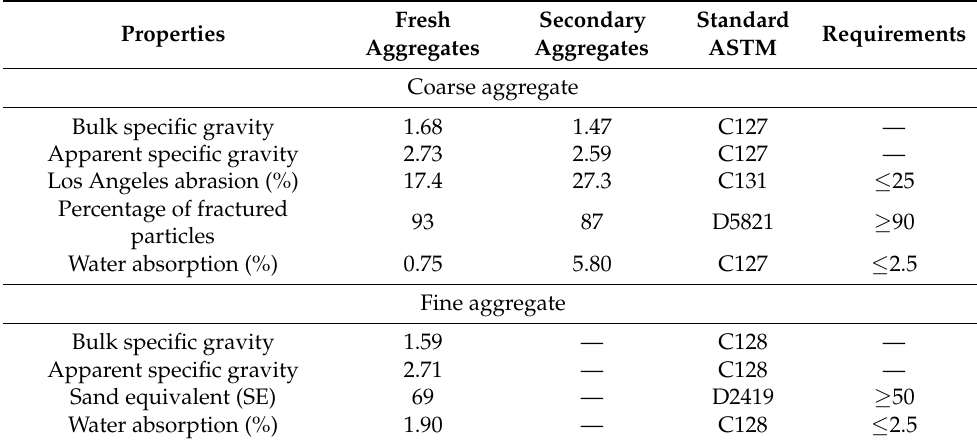
Table 2. Physical properties of aggregates.